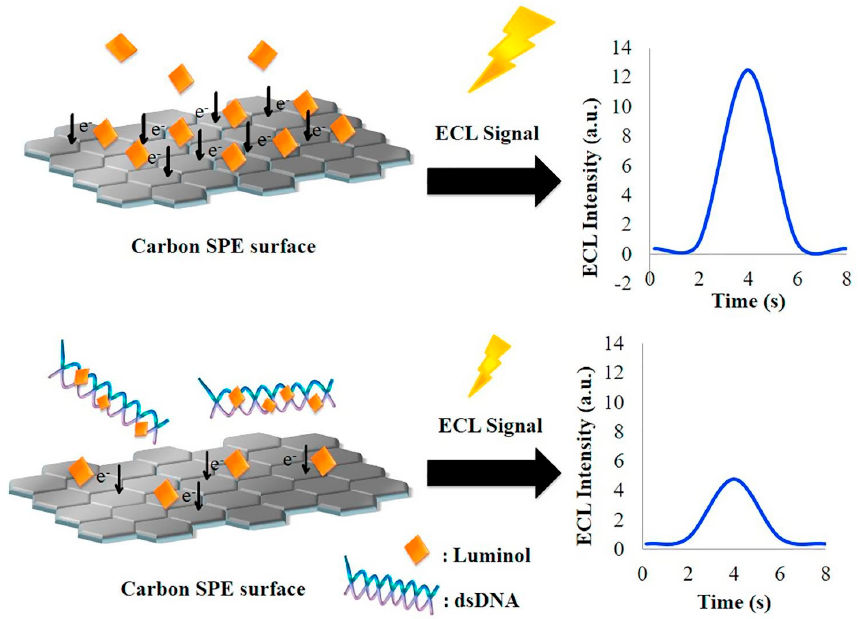
Figure 12. Schematic diagram of DNA ECL immunosensor development for detection of Susscrofa (Porcine) reported by Azam, N.F.N. et al. [169] . Reproduced and adapted with permission of Elsevier.